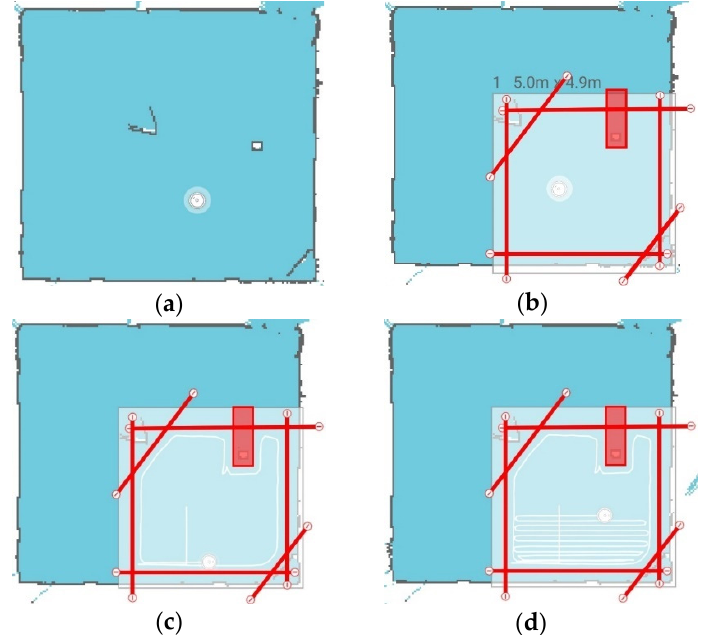
Figure 11. Setting up the cleaning zone using the Xiaomi Home mobile app. When placed in a new environment, the vacuum will build a map of its environment as shown in ( a ); the triangle in the rooms’ center is the cardboard deflectors placed on the Vive base stations stands (Figure 1). Within the app, walls and zones can be placed that will restrict the movement of the robot ( b ). Once initialized, the robot will then traverse the perimeter ( c ) before sweeping back and forth to cover the entire area ( d ).